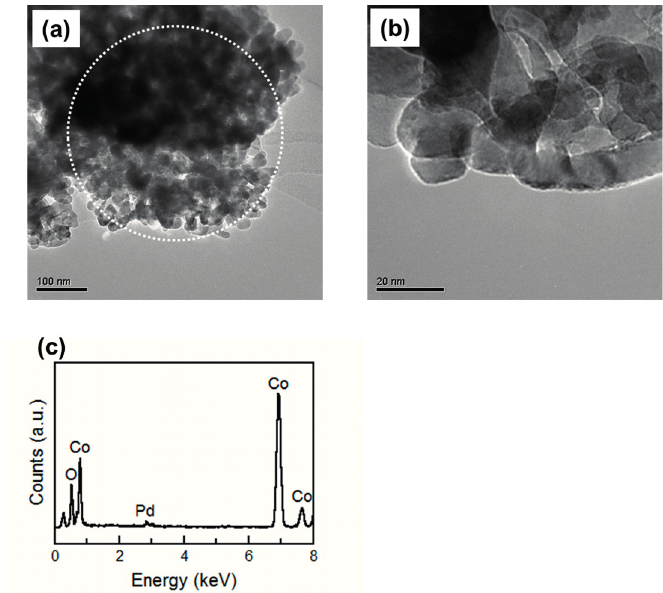
Figure 6. ( a , b ) TEM images of the 10%Pd/Co 3 O 4 powder; ( c ) EDX analysis result of the area inside the circle in the (a) image. The powder is baked at 400 °C for 2